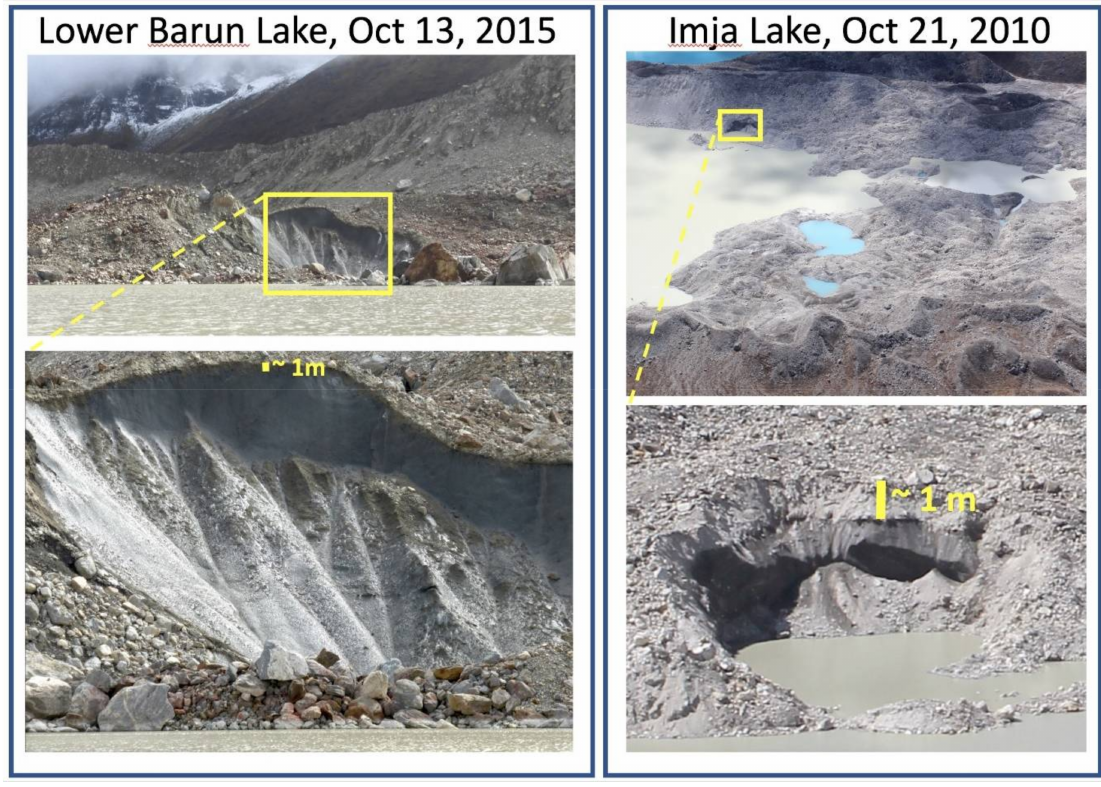
Figure 6. Ice-cored